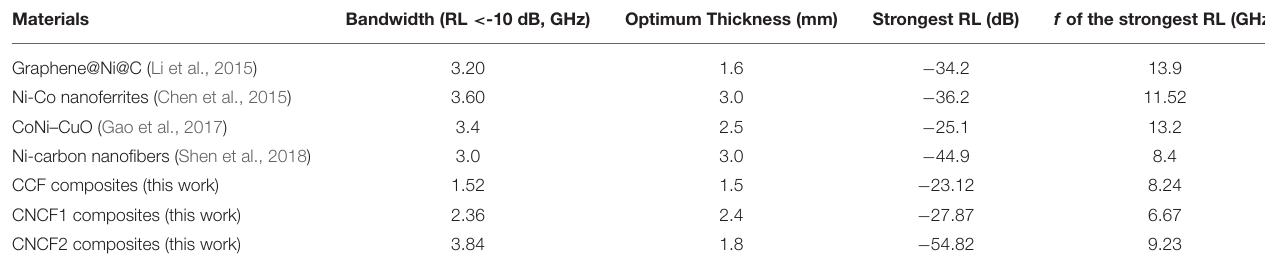
TABLE 1 | The best absorption bandwidths and corresponding parameters for CNCF composites vs. previously reported absorbers. Materials Bandwidth (RL < -10 dB, GHz) Optimum Thickness (mm) Strongest RL (dB) f of the strongest RL